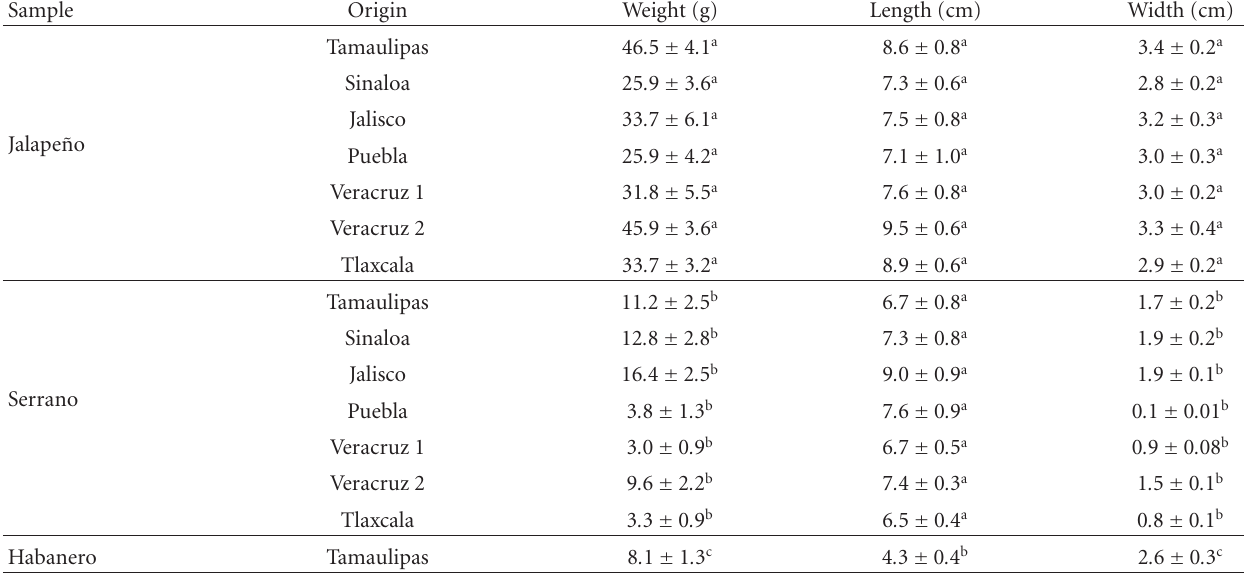
Table 2: Size and weight of the Serrano, Jalape˜no, and Habanero chilli pepper varieties.